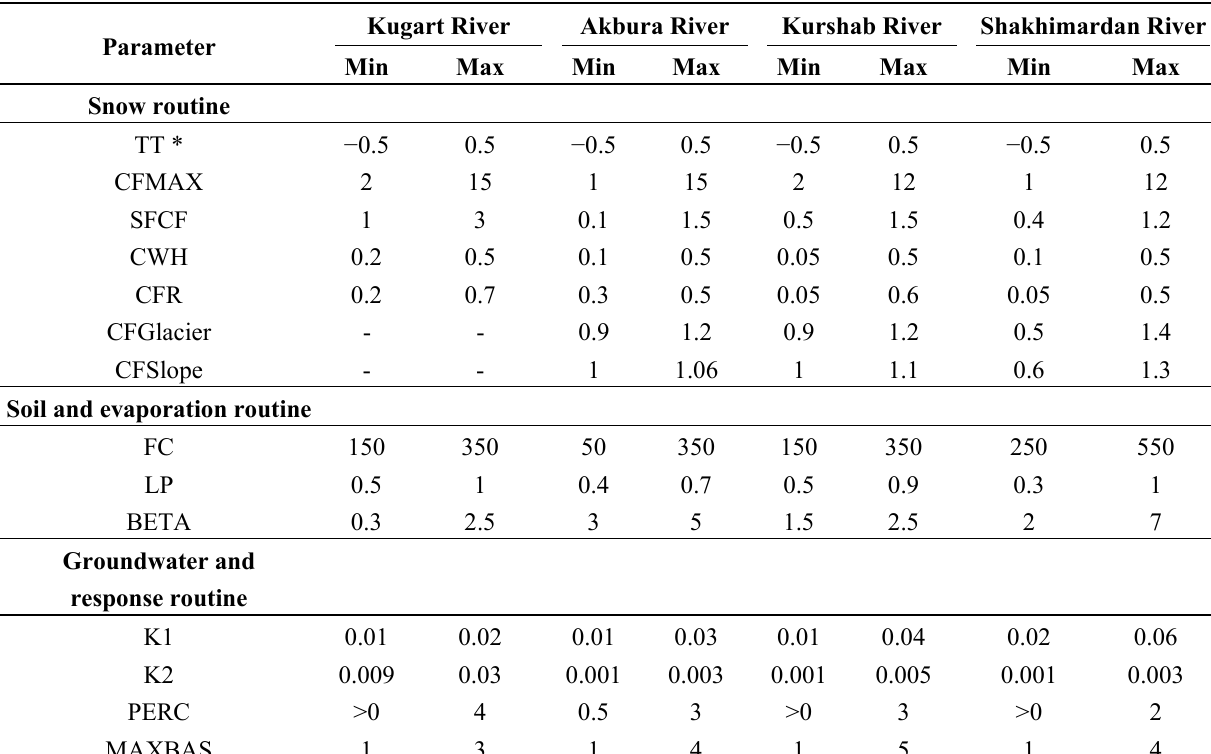
Table 6. Parameter ranges for the MODAWEC-generated temperature data allocated to the